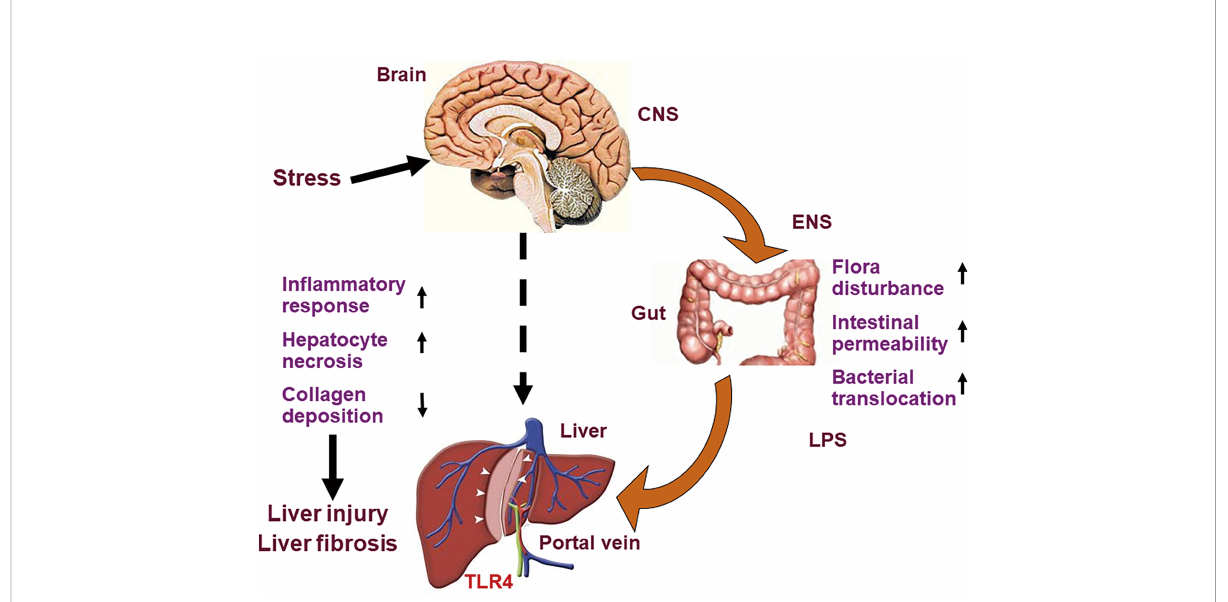
FIGURE 7 Diagram of brain-gut-liver axis. Chronic psychological stress induces changes of gut microbiota, increased intestinal permeability, bacterial translocation and increased LPS of portal vein blood, then triggers LPS-TLR4 pathway in liver, and promotes liver injury and fi brosis. LPS, lipopolysaccharide; TLR4, toll-like receptor